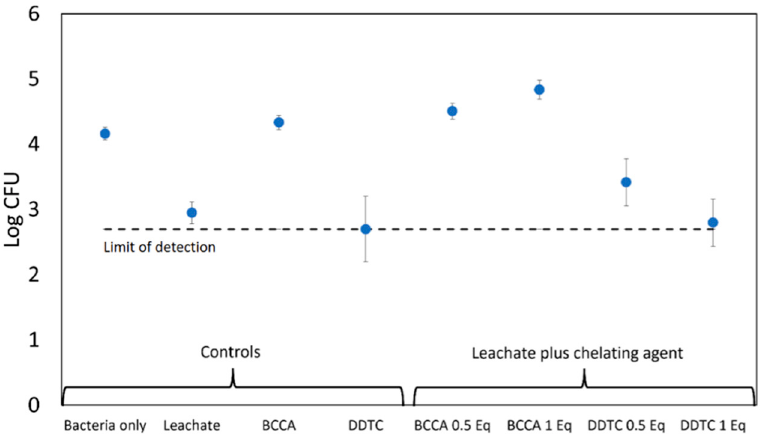
Figure 6. The activity of Cu 2 O leachate on MRSA in drying droplets containing both leachate and suspended MRSA. 0.5 Eq. means that the concentration of the chelating agent was 0.5 of the amount needed to chelate the copper ions, etc. DDTC becomes toxic when dried. BCCA maintains its protective effect against copper ions. Blue circles represent the average of three independent points and the error bars represent 95% confidence intervals for each condition.